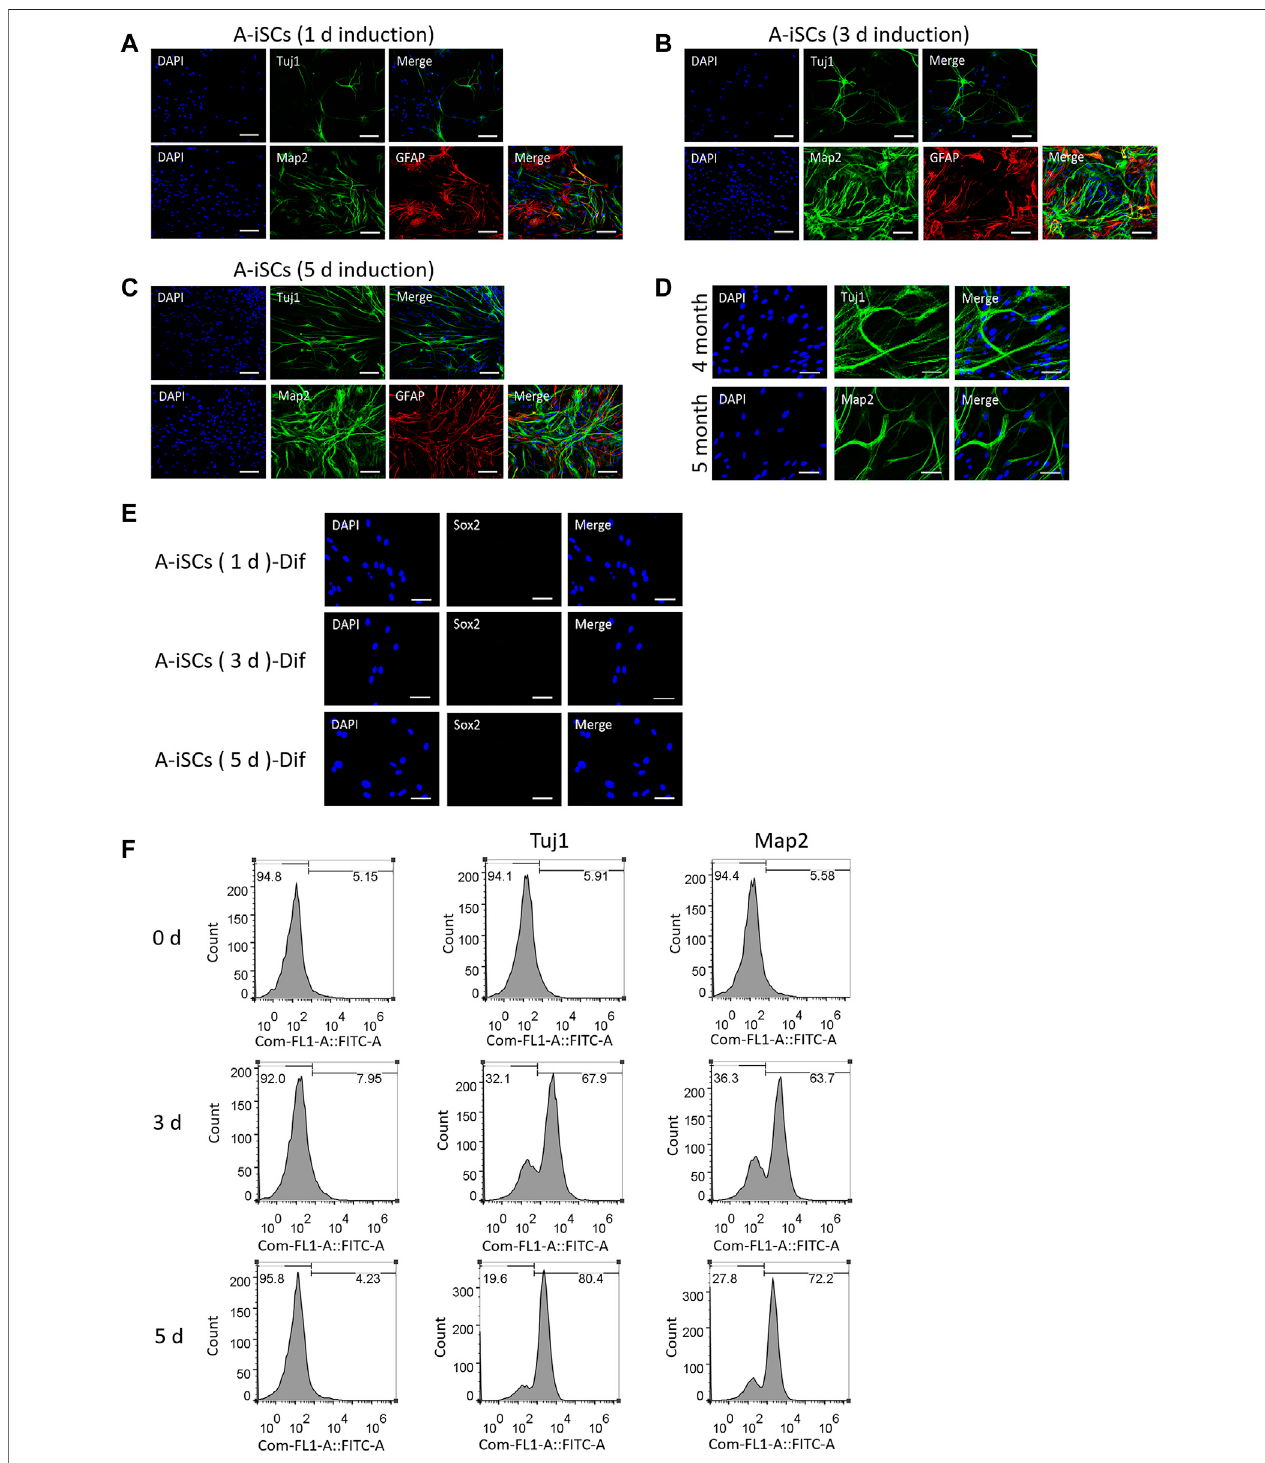
FIGURE 3 | In vitro differentiation of A-iSCs derived from ASTs induced in spheres for 1 day (A) , 3 days (B) and 5 days (C) , respectively. Scale bars of (A – C) : 100 μ m. (D) Neurons converted from A-iSCs survived for > 5 months. Scale bar: 50 μ m. (E) Expression of Sox2 in differentiated A-iSCs derived from ASTs induced in spheresfor1,3,and5 days,respectively.A-iSCs(1 day)-Dif:DifferentiationofA-iSCsderivedfromASTsinducedinspheresfor1 day;A-iSCs(3 days)-Dif:Differentiation of A-iSCs derived from ASTs induced in spheres for 3 days; A-iSCs (5 days)-Dif: Differentiation of A-iSCs derived from ASTs induced in spheres for 5 days. Scale bar: 50 μ m. (F) Expression of neuron-speci fi c markers in differentiated A-iSCs derived from ASTs induced in spheres for 0 (2D culture), 3 and 5 days, respectively.